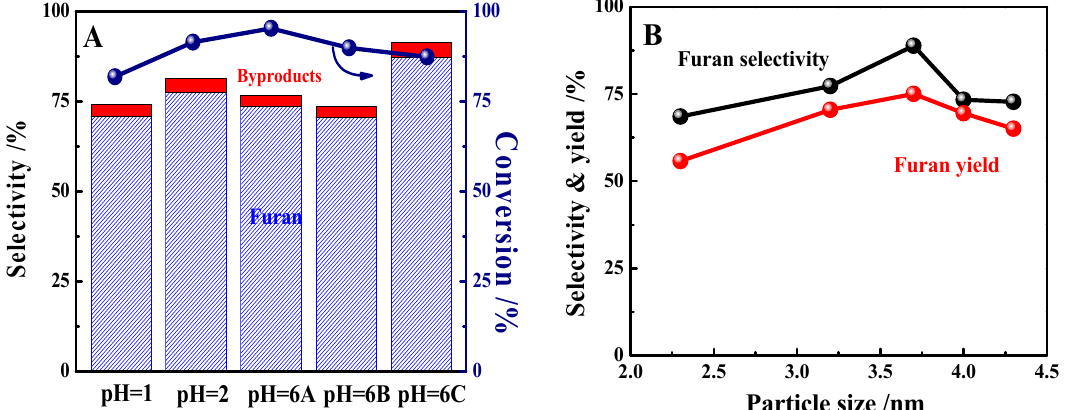
Figure 5. ( A ) Furfuran conversions over Pt/SBA-15 catalysts prepared under different conditions (furfural conversion and furan selectivity are the average values from 2 to 6 h time on stream (TOS) shown in Figure S7) and ( B ) effect of Pt particle size on furan selectivity and yield (reaction conditions: 573 K, WHSV = 16.5 h − 1 , H 2 / furfural (mol) = 2.4). Note: besides furan as the major product, byproducts including 2-methylfuran (2-MF) and 2-methyltetrahydrofuran (2-MTHF) were detected in the reaction, accounting for the ca. 0.7–4.8% selectivity.